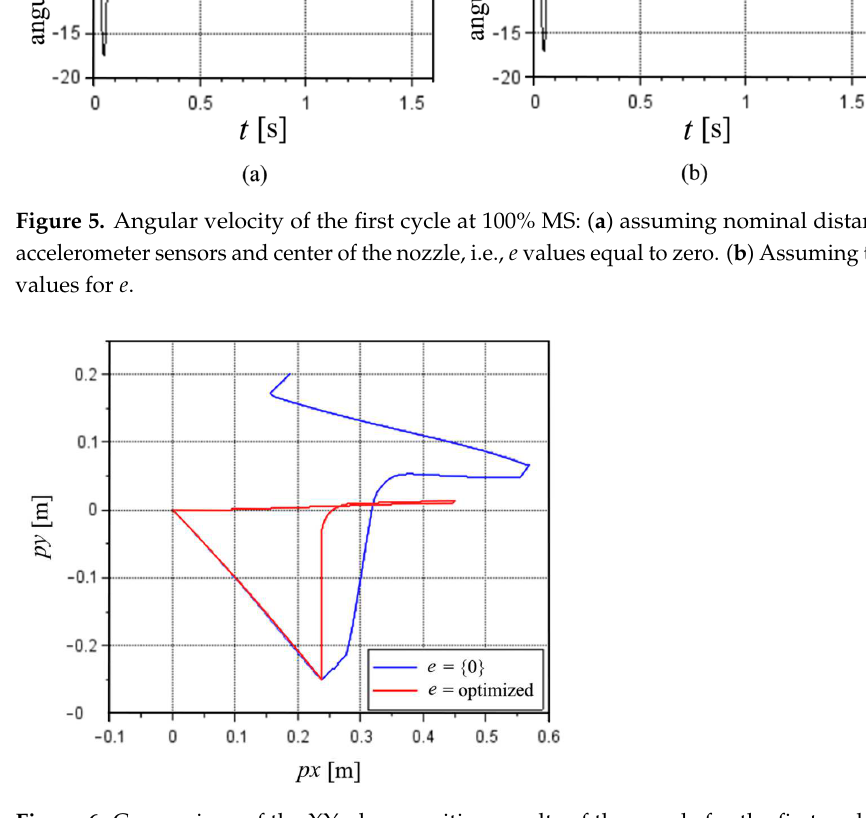
values equal to zero. ( b ) Assuming the opti- :